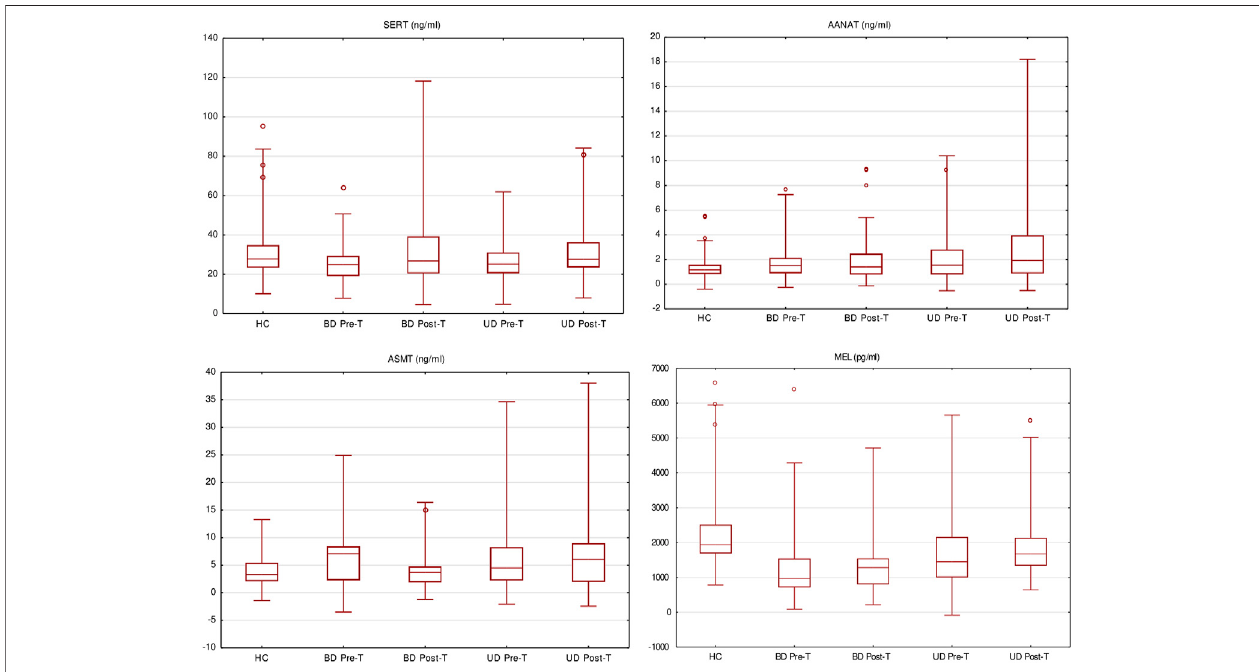
TABLE 4 | Differentially expressed genes (DEGs) in studied models. Model Total DEGs, Clinical model Agomelatine (+) vs. HC Cell culture model Melatonin (+) vs. melatonin ( − ) 18,489 FC, fold change; PBMC, peripheral blood mononuclear cells; HN, hippocampal neurons. a Functionally known by the DAVID/KEGG